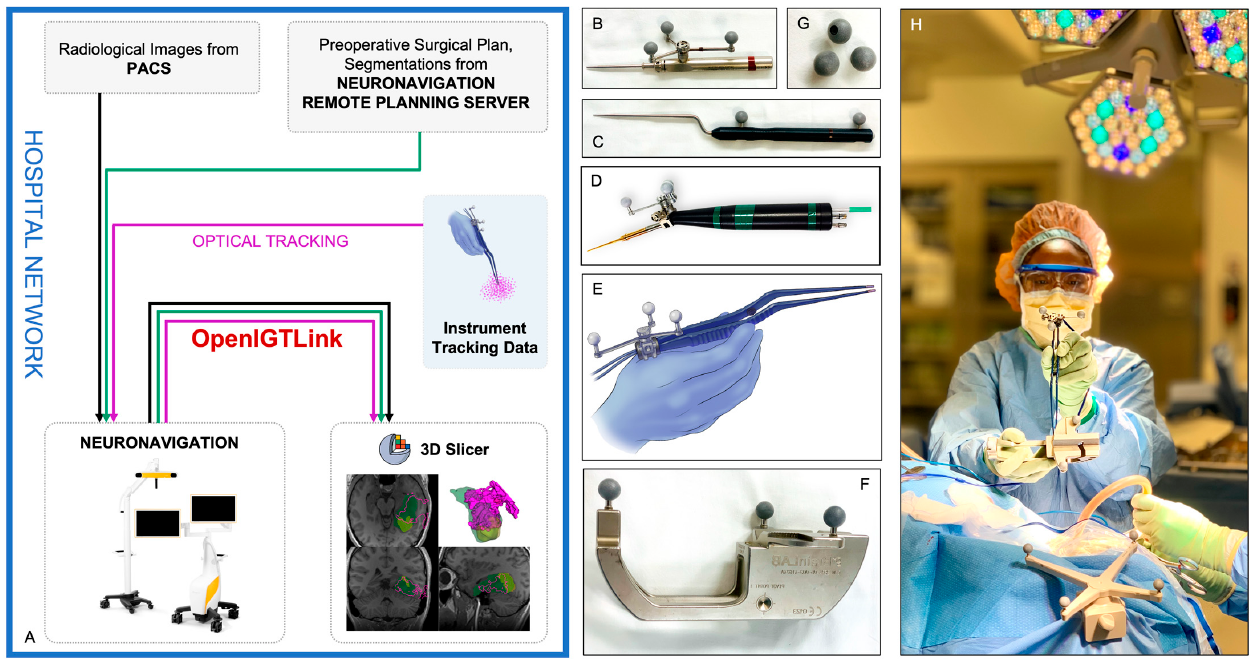
Figure 2. Panel A —Schematic of the network connections with the direction of data flow between the various software components used in our technique. Preoperative and intraoperative radiological